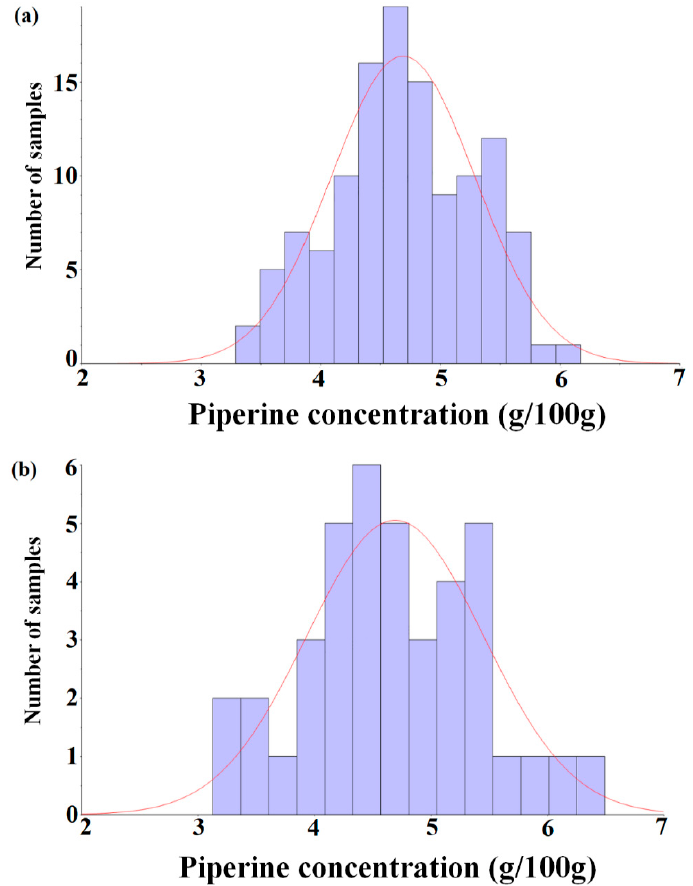
Figure 1. Histogram of the piperine concentration of the calibration set ( n = 120, ( a )) and prediction set ( n = 40, ( b )).